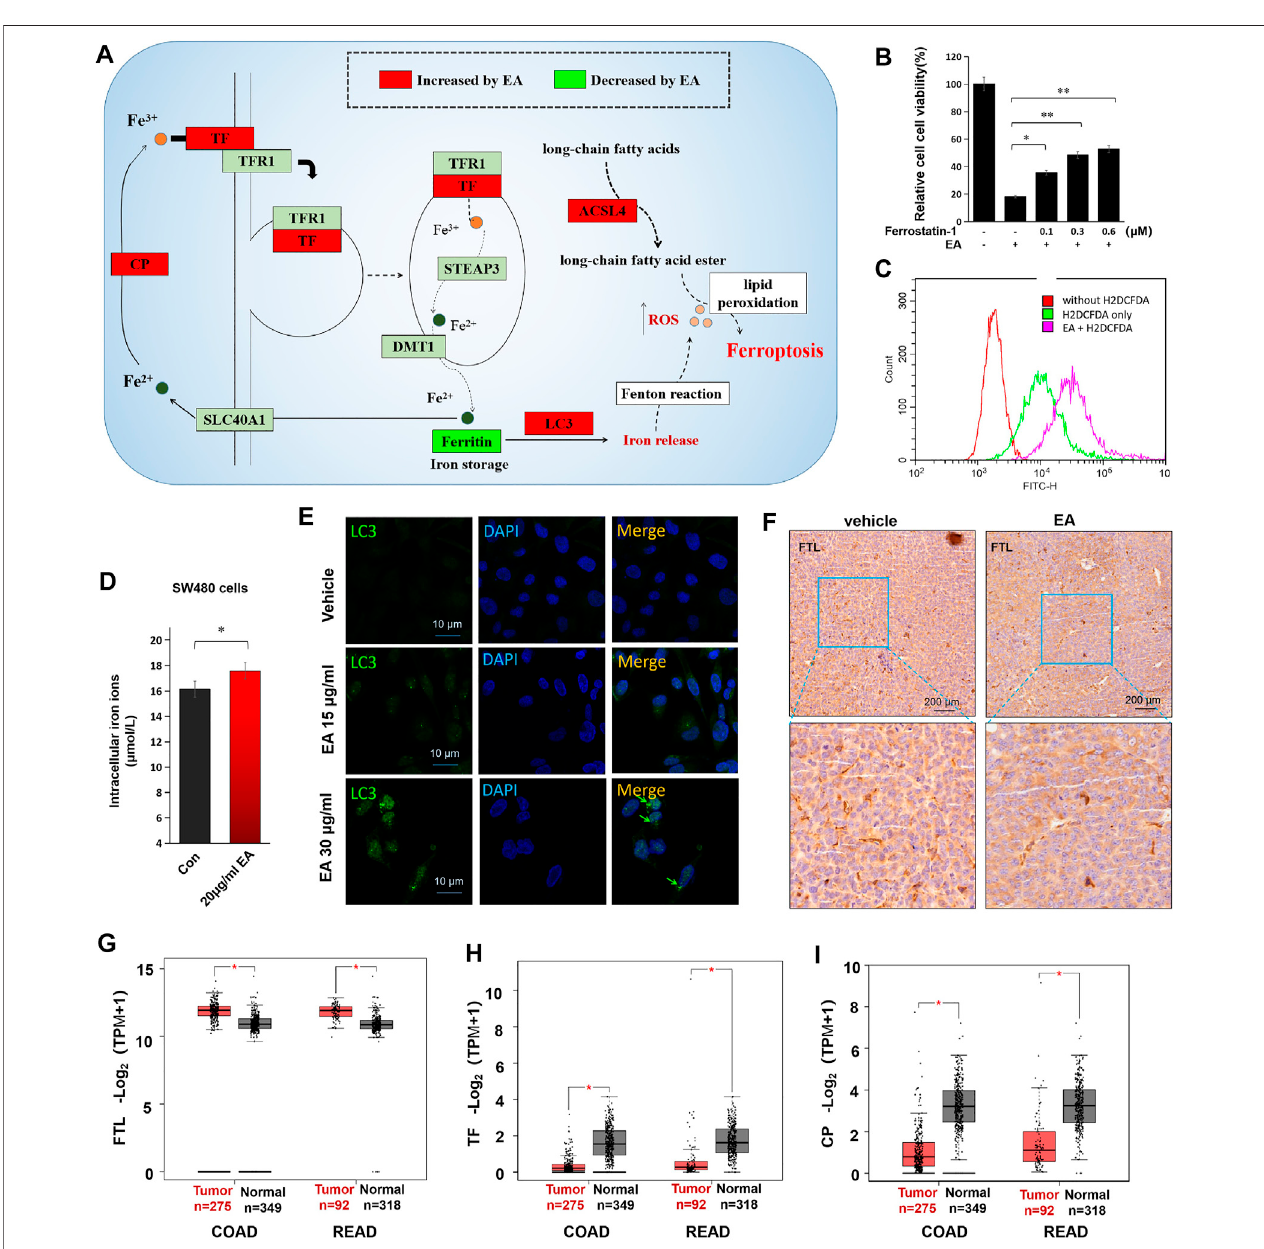
FIGURE6| EAinducedcolorectalcancercelldeath via triggeringferroptosis. (A) Thealterationofferroptosis-relatedproteinscausedbyEAtreatment(thediagram was drawn according to proteomic results and ferroptosis KEGG map). (B) The rescue effects of ferrostatin-1 (an iron death inhibitor) on the 20 μ g/ml EA-induced cell inactivation were detected by the CCK8 kit. The difference between two groups was calculated by a two-way t -test, * p < 0.05, ** p < 0.01. (C) EA-induced intracellular ROS was tested by H2DCFDA. The red curve represented the background without the ROS probe, the green curverepresented the ROS intensity of cells without EA treatment, and the rose-pink curve represented the ROS intensity of EA-treated cells. The EA concentration in this experiment was 20 μ g/ml. (D) The alteration of intracellular iron concentrations of EA-treated SW480 cells. The difference between two groups was calculated by atwo-way t -test, * p < 0.05. (E) The EA-elevated LC3 was veri fi ed by cell immuno fl uorescence experiment in SW480 cells. LC3 was stained by green fl uorescence and the nucleus was stained by DAPI with blue fl uorescence. (F) The EA-repressed ferritin (FTL) was examined by IHC in xenograft tumors. The FTL was stained with brown color, and the nucleus was stained by hematoxylin (purple). (G – I) The expression of FTL, TF and CP in clinical colorectal cancer tissue and normal tissue. Data were from the online platform GEPIA (http:// gepia.cancer-pku.cn/index.html). COAD: Colon adenocarcinoma; READ: Rectum adenocarcinoma, * p < 0.05.